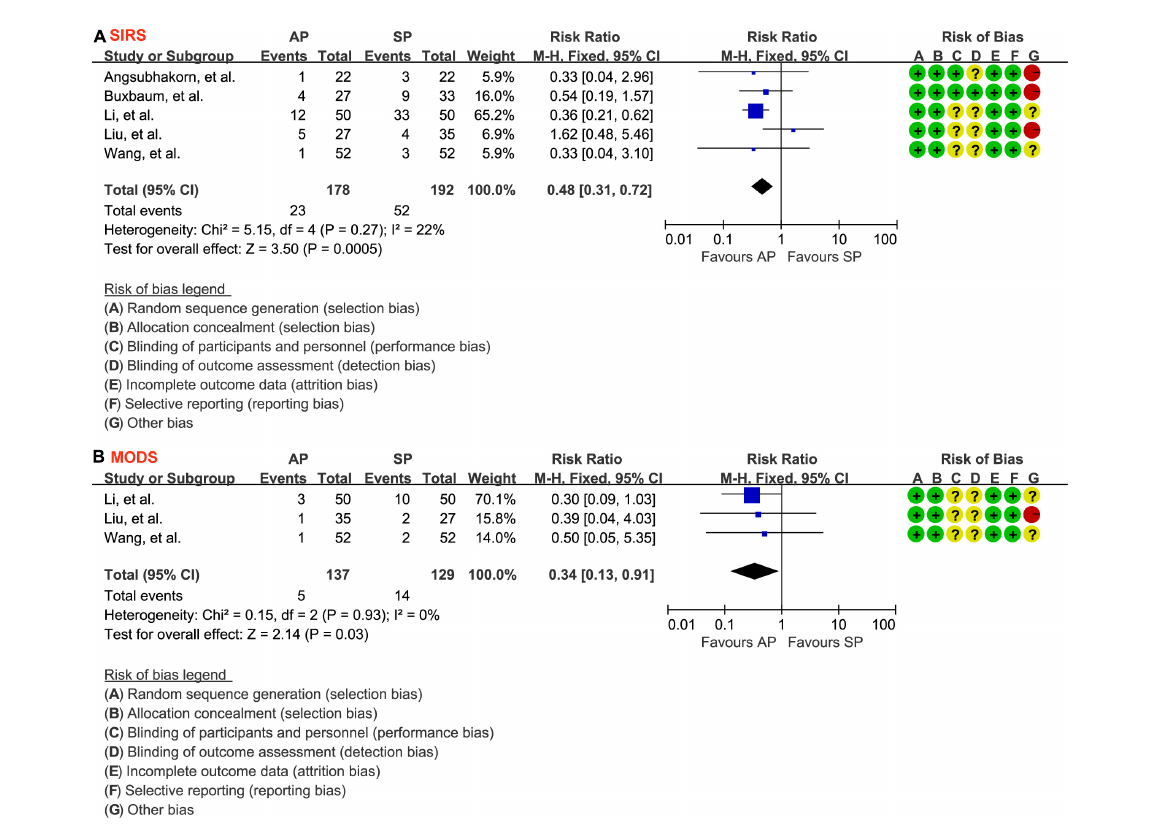
FIGURE4 Forest plot of the development of SIRS (A) and MODS (B) . SIRS, systemic inflammatory response syndrome; MODS, multiple organ dysfunction syndrome; AP, aggressive hydration protocol; SP, standard hydration protocol; CI, confidence interval; M-H,